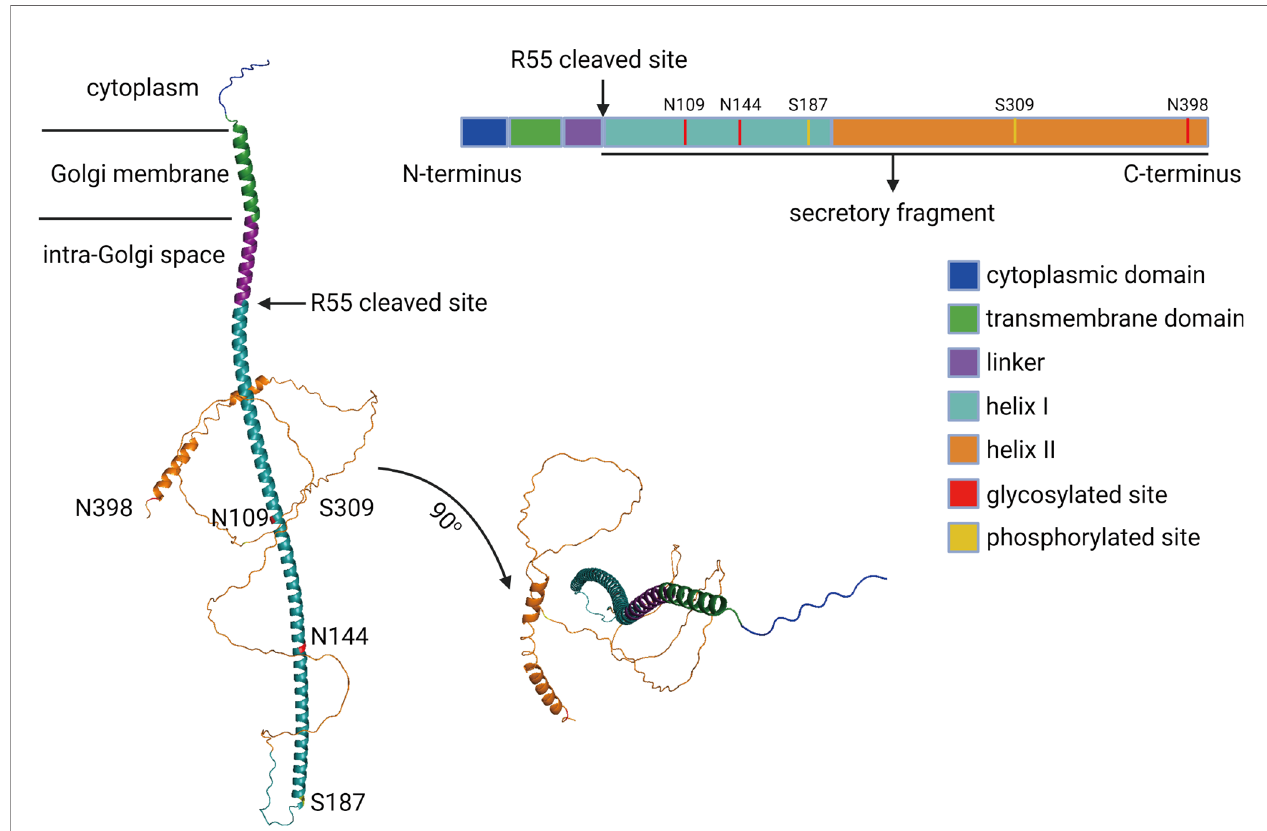
FIGURE 1 | The schematic diagram of GP73. The functional domains, phosphorylated sites, and glycosylated sites of full-length GP73 has been showed. The predicted molecular structure of GP73 was obtained from AlphaFold Protein Structure Database